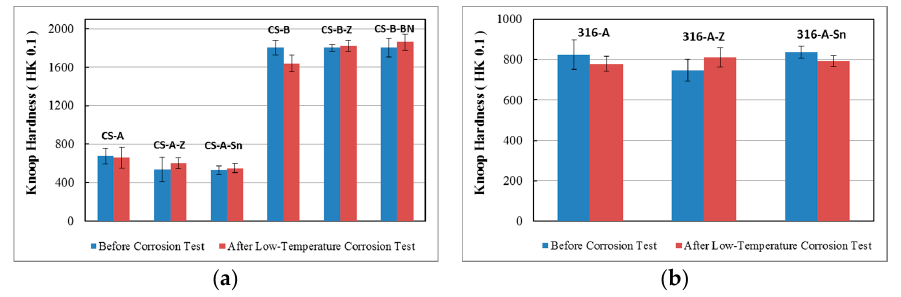
Figure 15. Comparison of Knoop hardness of the case depth before and after the low-temperature corrosive attack for ( a ) coated low carbon steel, and ( b ) coated 316 stainless steel substrates.